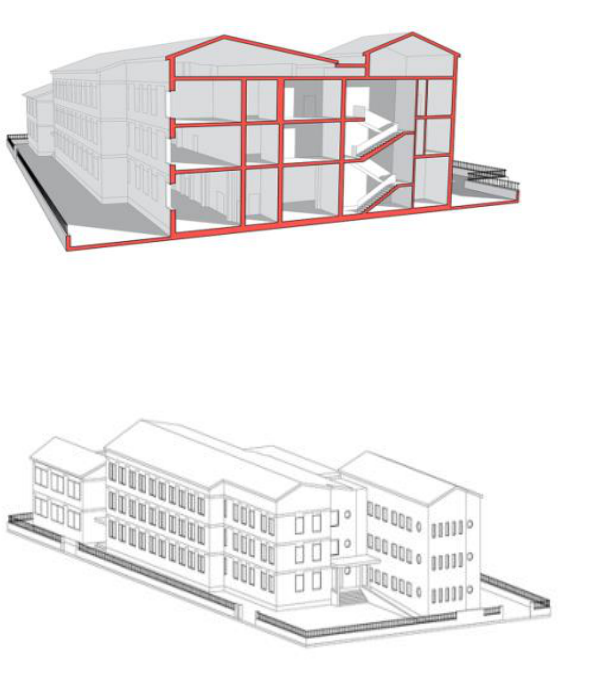
Figure 7. Section and axonometric synthesis of the G. Pascoli school.